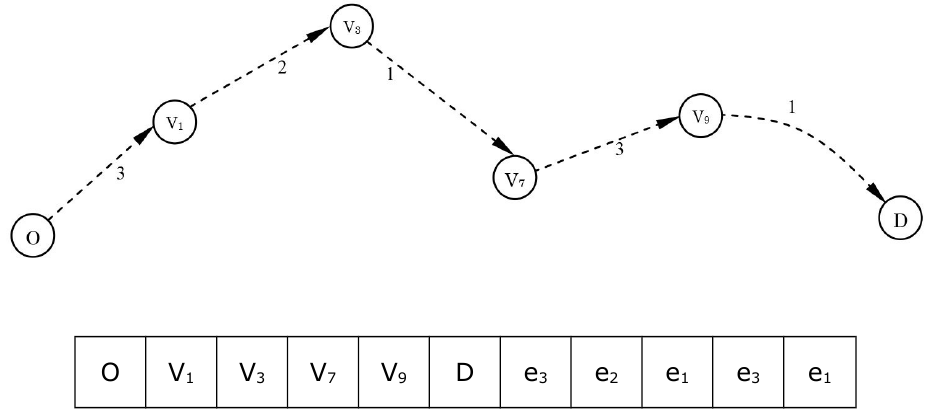
Figure 2. The encoding method of OD